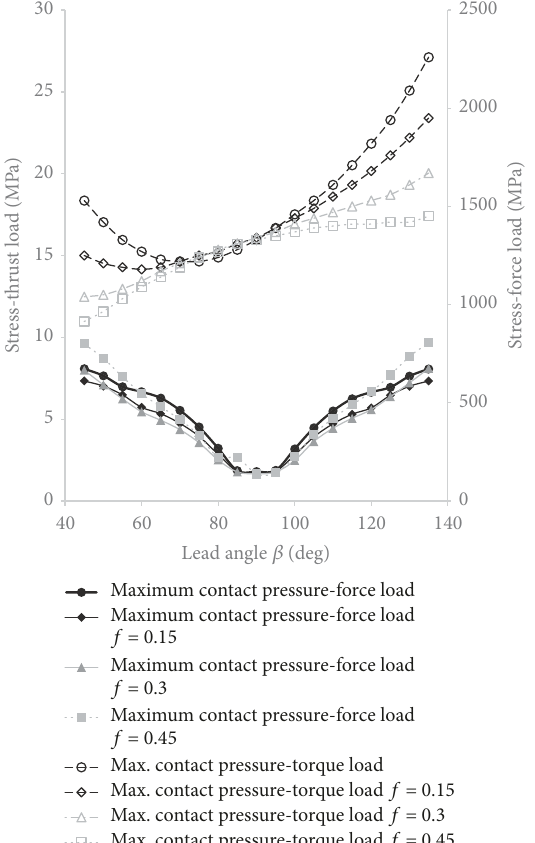
Figure 11: Maximum contact pressure for different lead angles underaxialforceload(leftordinate)andtorqueload(rightordinate) calculated by means of FEM model without and with friction.